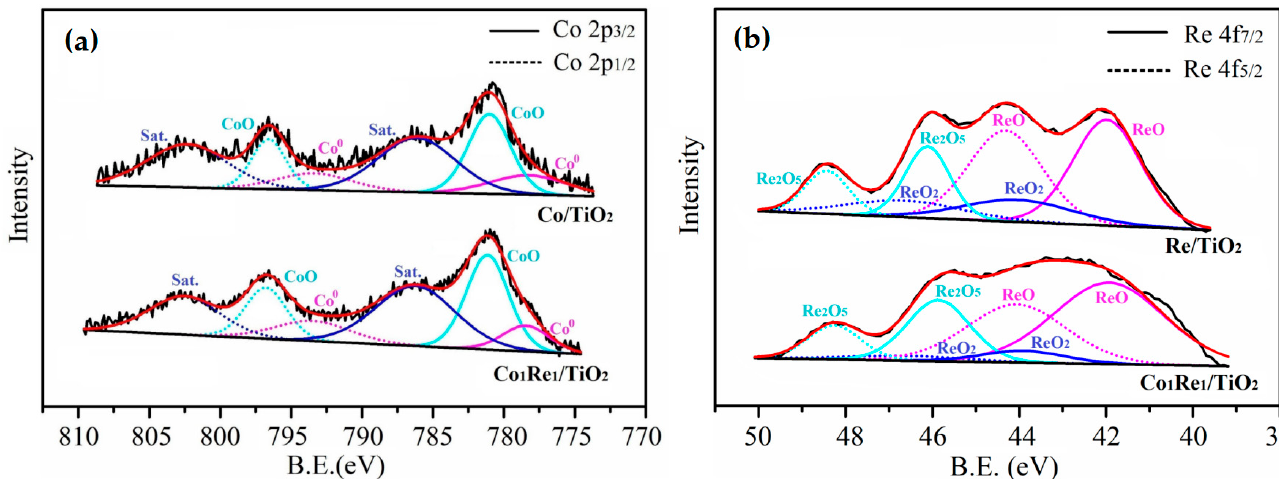
Figure 3. XPS spectra of ( a ) Co 2p and ( b ) Re 4f of the reduced catalysts Co/TiO 2 , Re/TiO 2 and Co 1 Re 1 /TiO 2 .